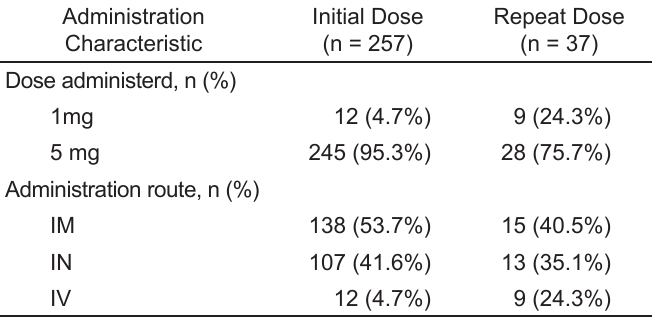
Table 2. Characteristics of midazolam administrations for behavioral